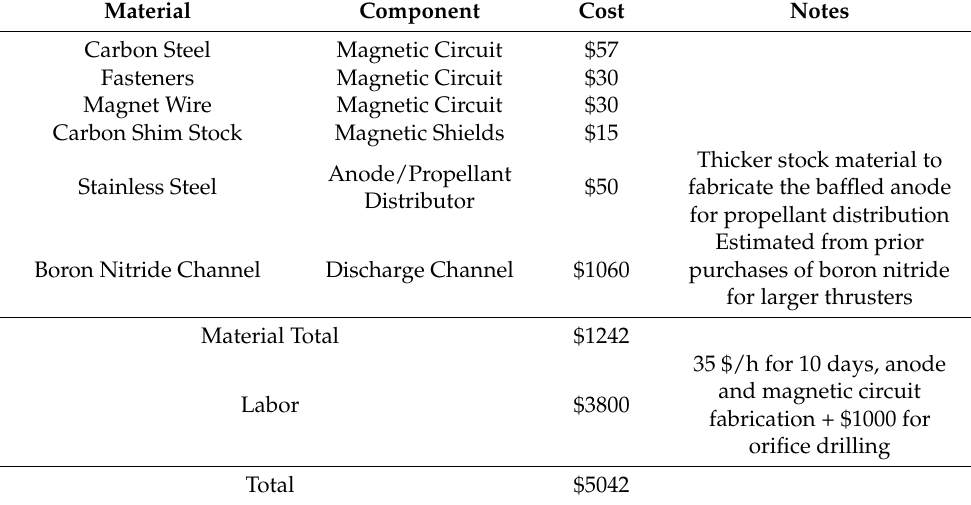
Table 2. UAH-78AM cost